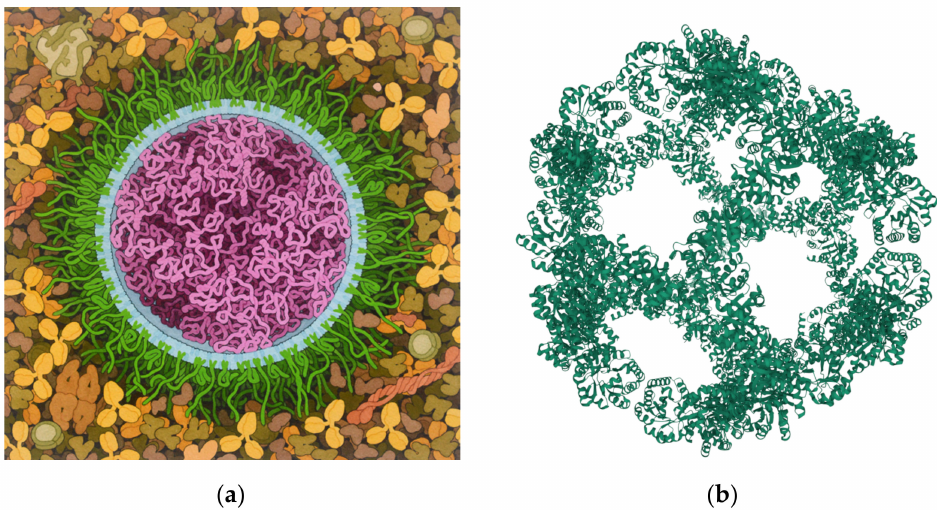
Figure 4. Structures of nanoparticles used for COVID-19 vaccine candidates: ( a ) mRNA vaccines realized for the COVID-19 pandemic are composed of long strands of RNAs (magenta) that encode the SARS-CoV-2 S protein enclosed in lipids (cyan), connected with lipids conjugated to polyethylene glycol (PEG) chains (green), that deliver the RNA cargo into recipient cells. In the idealized illustration by David S. Goodsell, RCSB Protein Data Bank [113], the lipids are arranged in a simplified model of a circular bilayer surrounding the mRNAs, and the PEG chains are endowed with both folded and extended conformations. Note how the real structure may be less regular, as suggested in the literature [110]. ( b ) An example of protein nanoparticle-based vaccine proposed against SARS-CoV-2. It displays the S glycoprotein receptor-binding domain (RBD) on a synthetic virus-like particle platform, SpyCatcher003-mi3, and uses SpyTag/SpyCatcher technology [112] (https://www.rcsb. org/structure/7B3Y, accessed on 4 February